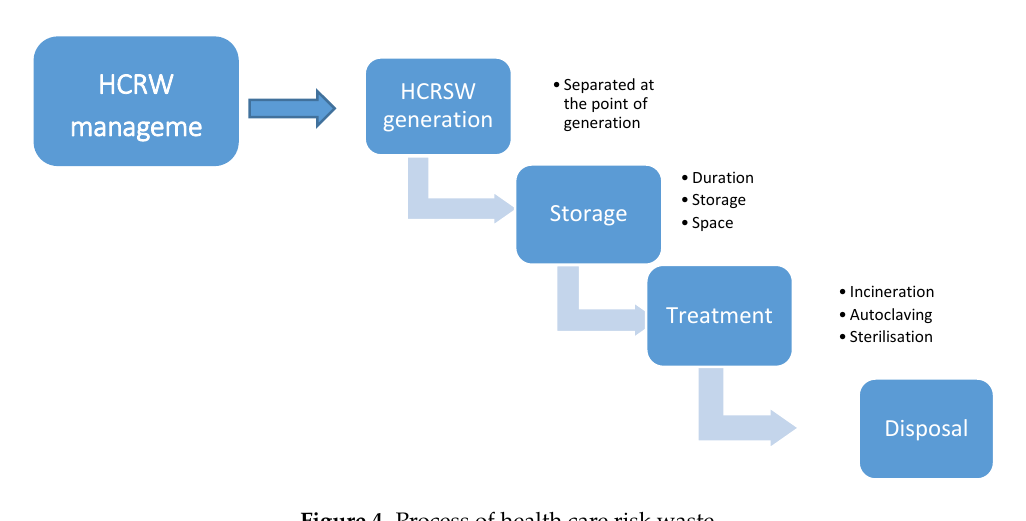
Figure 4. Process of health care risk waste.